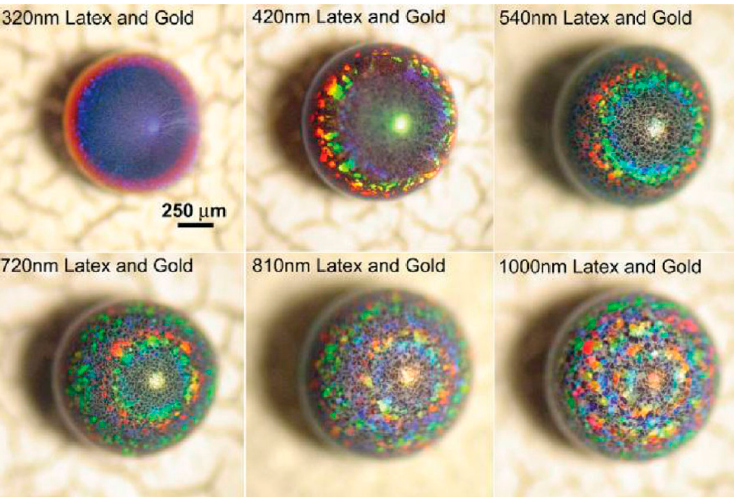
Figure 13. Optical microscopy images of patchy supraparticles assembled by EISA using variably-sized polystyrene (PS) latex nano-/micro-particles in suspension droplets generating highly light diffracting “opal balls”. The gold nanoparticles are 22 nm in size. Reprinted with permission from [97] (p. 4266). Copyright 2008 Wiley.